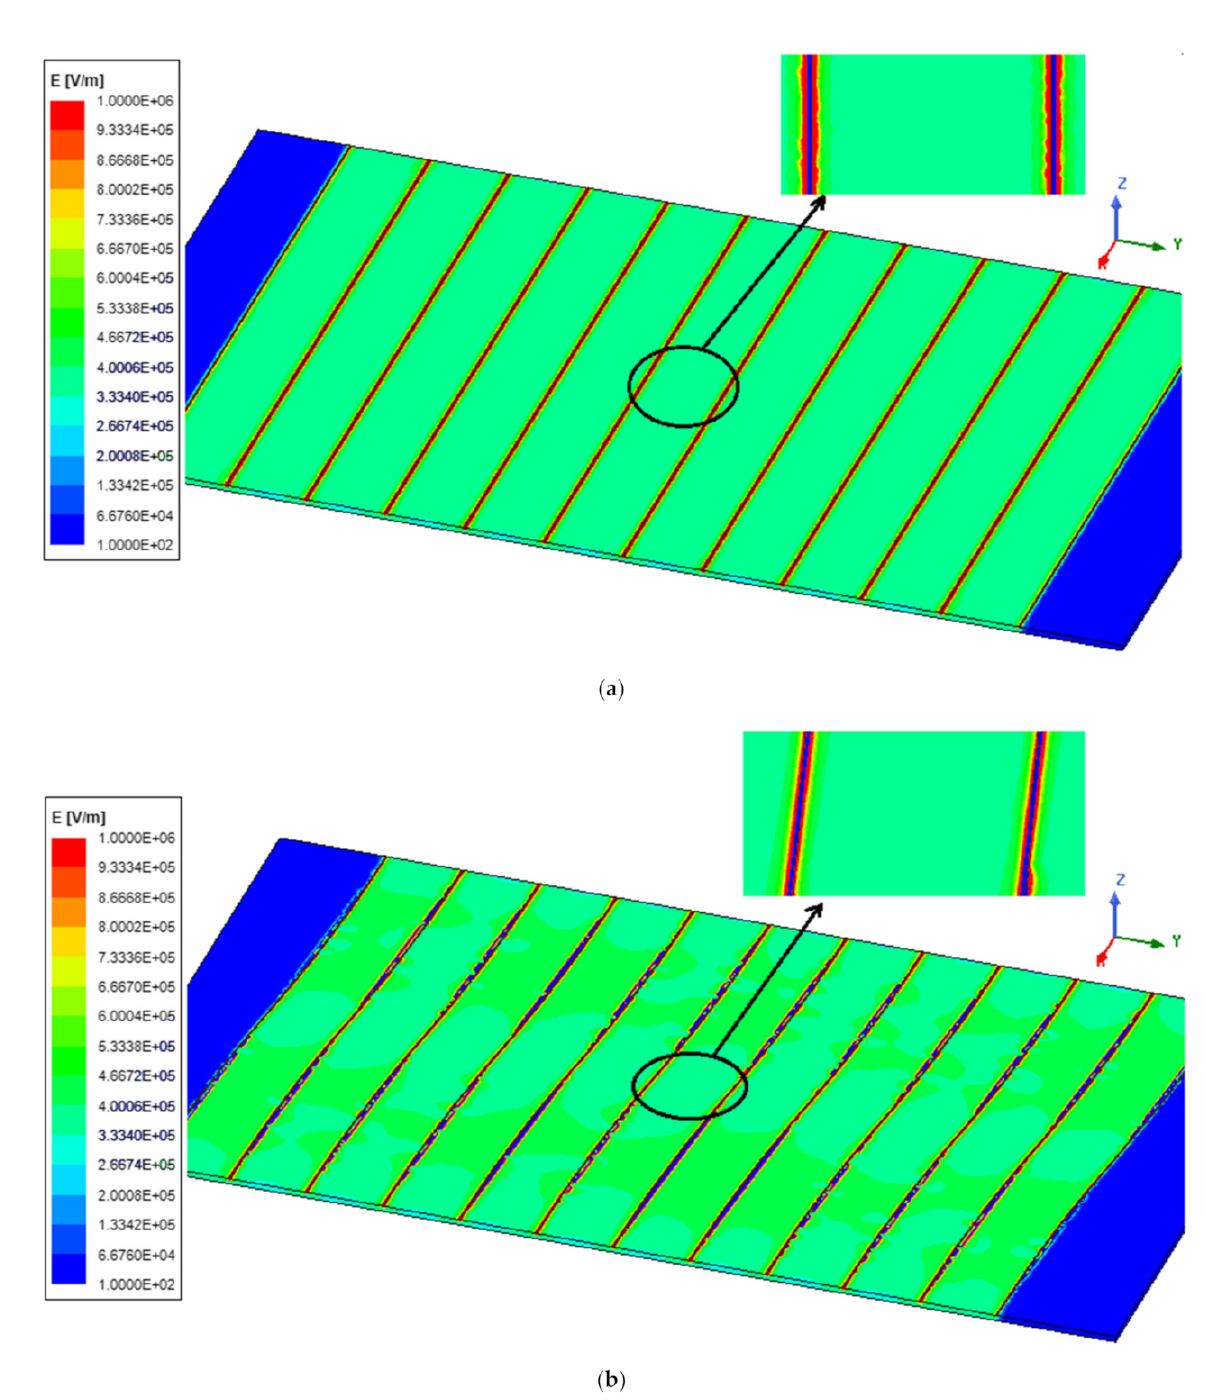
Figure 3. 3D FEA electric field distribution: ( a ) M1 model, ( b ) M2